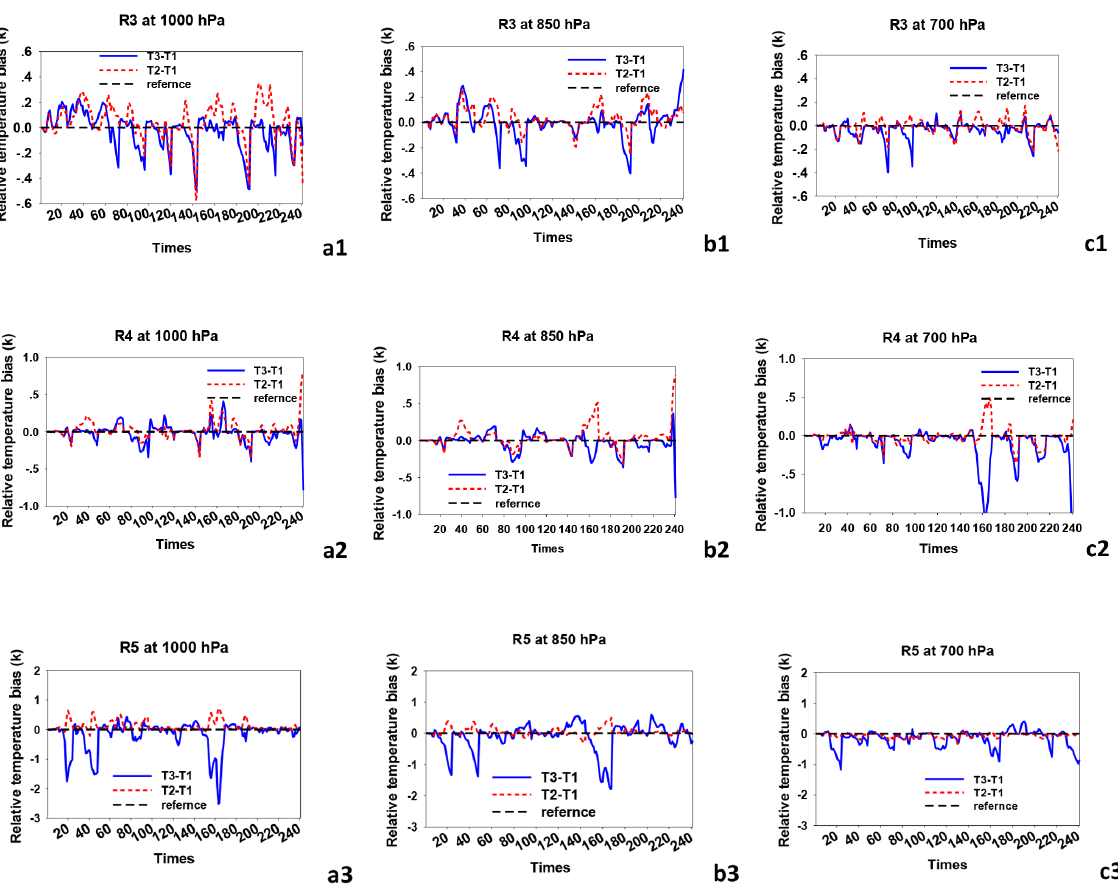
Figure 7. Temperature bias differences between T3 and T1, and T2 and T1 at heights of 1000, 850, and 700hPa for the regions of R3 (a1 – a3) , R4 (b1 – b3) , and R5 (c1 – c3) .